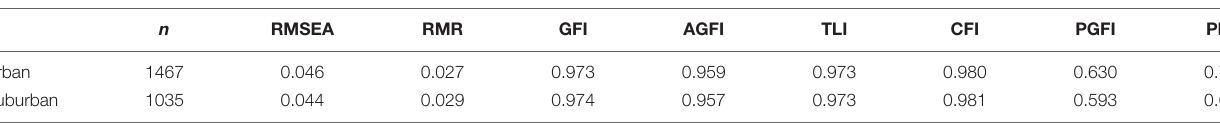
TABLE 3 | The goodness of fit index (GFI) of urban and suburban groups.